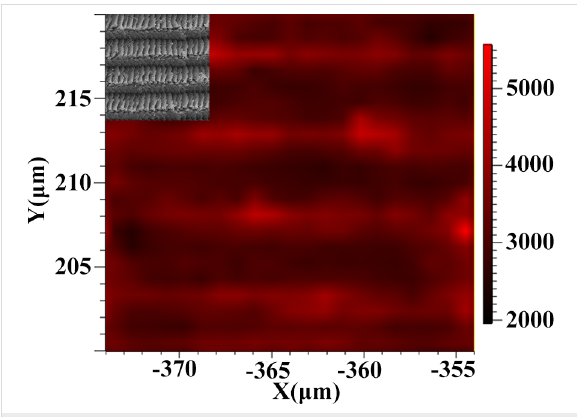
Figure 7: Raman intensity mapping image of the arrayed Ag/Cu sub- strate with a feed of 5 μ m in the x -direction and 1 μ m in the y -direction.